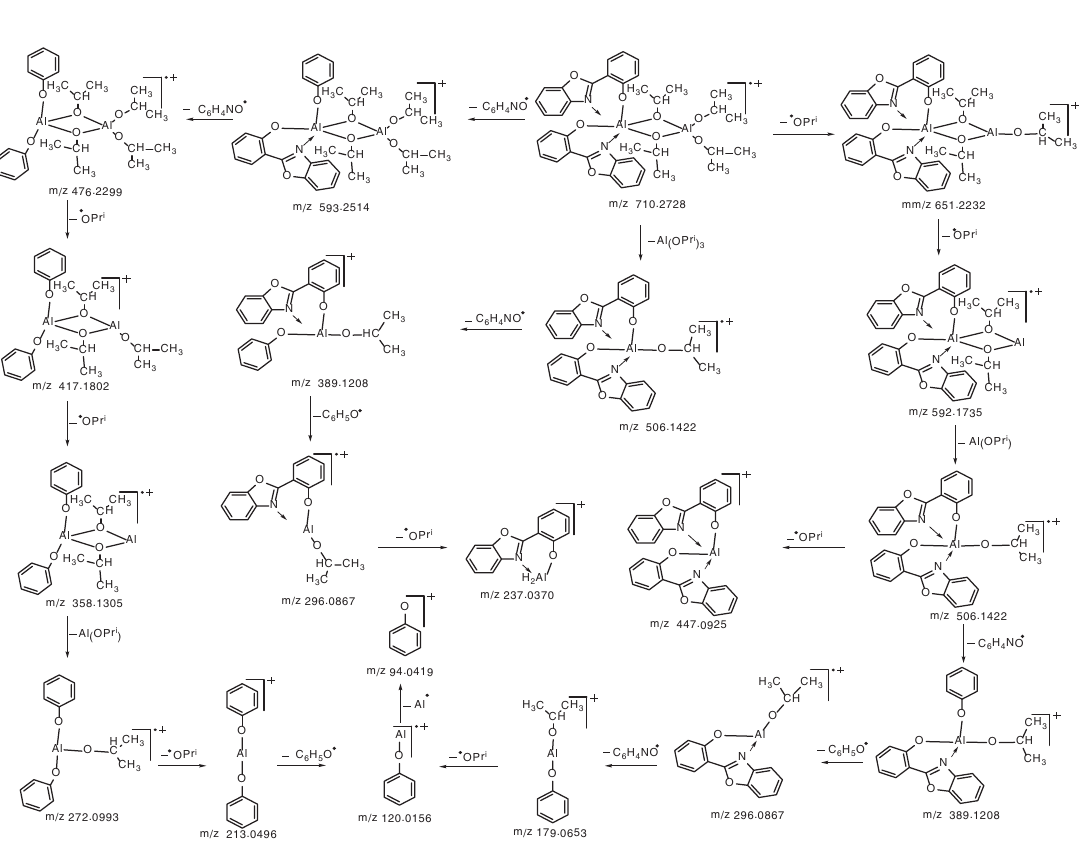
Figure 1: 27 Al NMR spectrum of complex [( μ -OPr i )